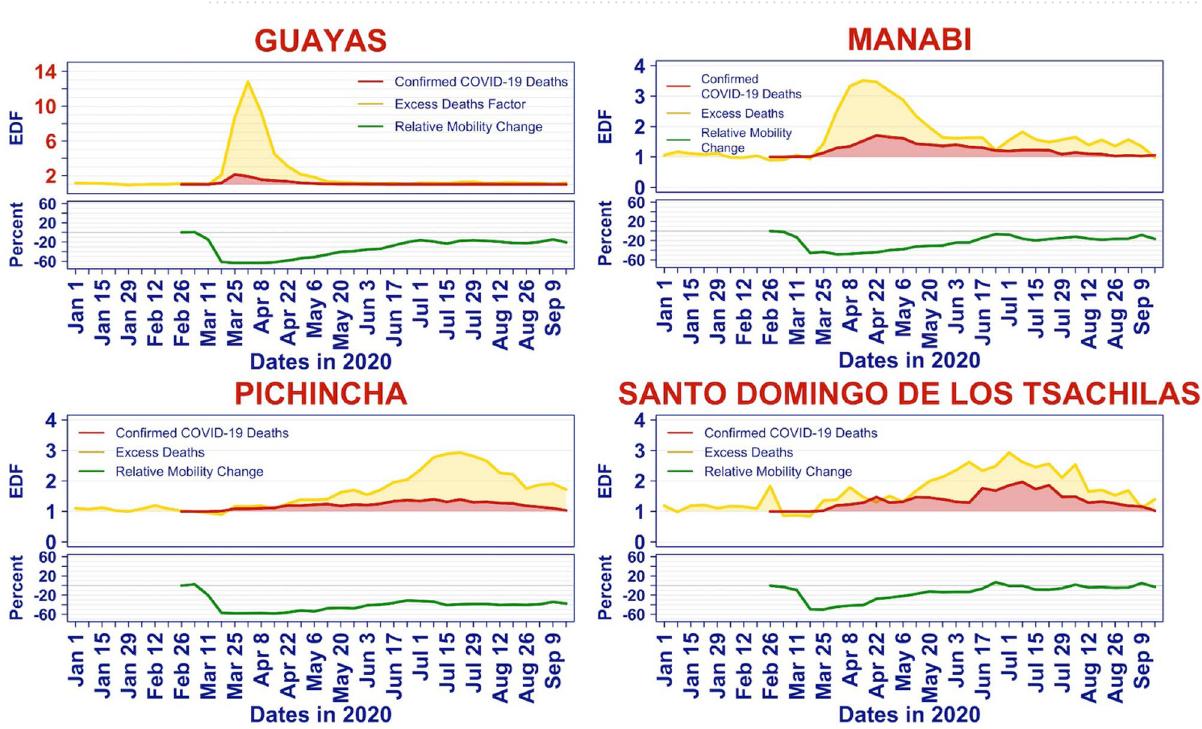
Figure 7. Time series of excess death factor, confirmed COVID-10 deaths, and median